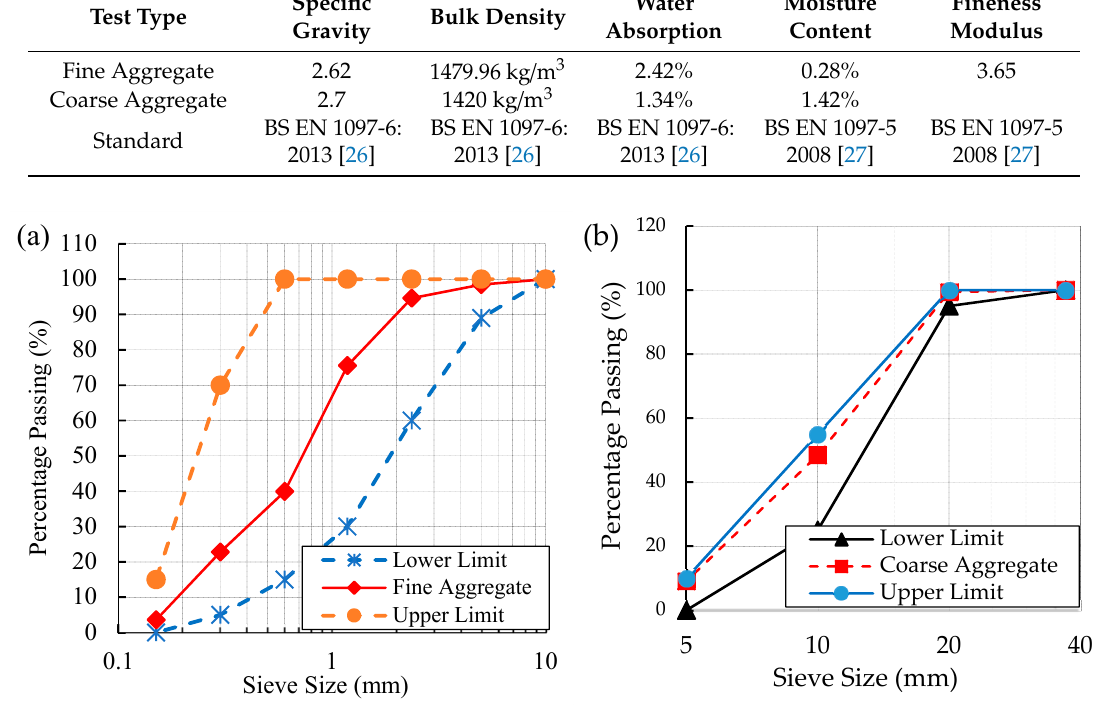
Figure 1. Aggregate grading: ( a ) fine aggregate, ( b ) Coarse aggregate.